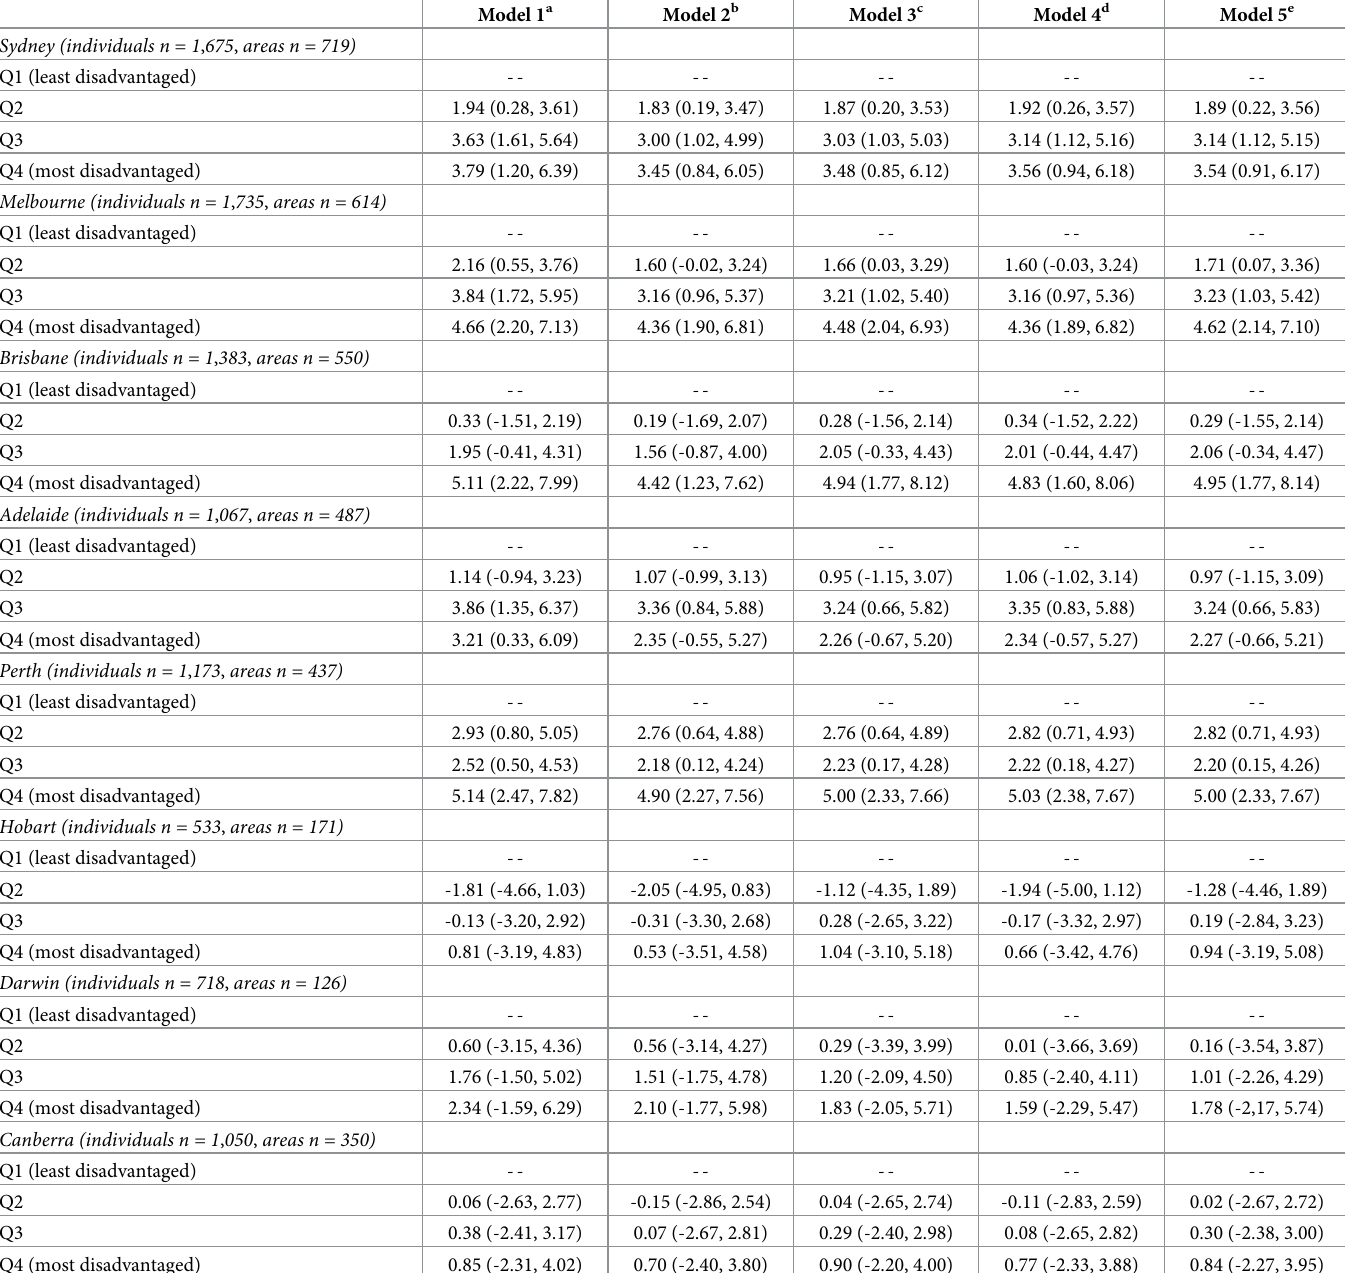
Table 5. Neighbourhood disadvantage and waist circumference (cm), before and after adjustment for residential distance to the CBD, supermarket availability, and walkable amenities, by capital city (multilevel linear